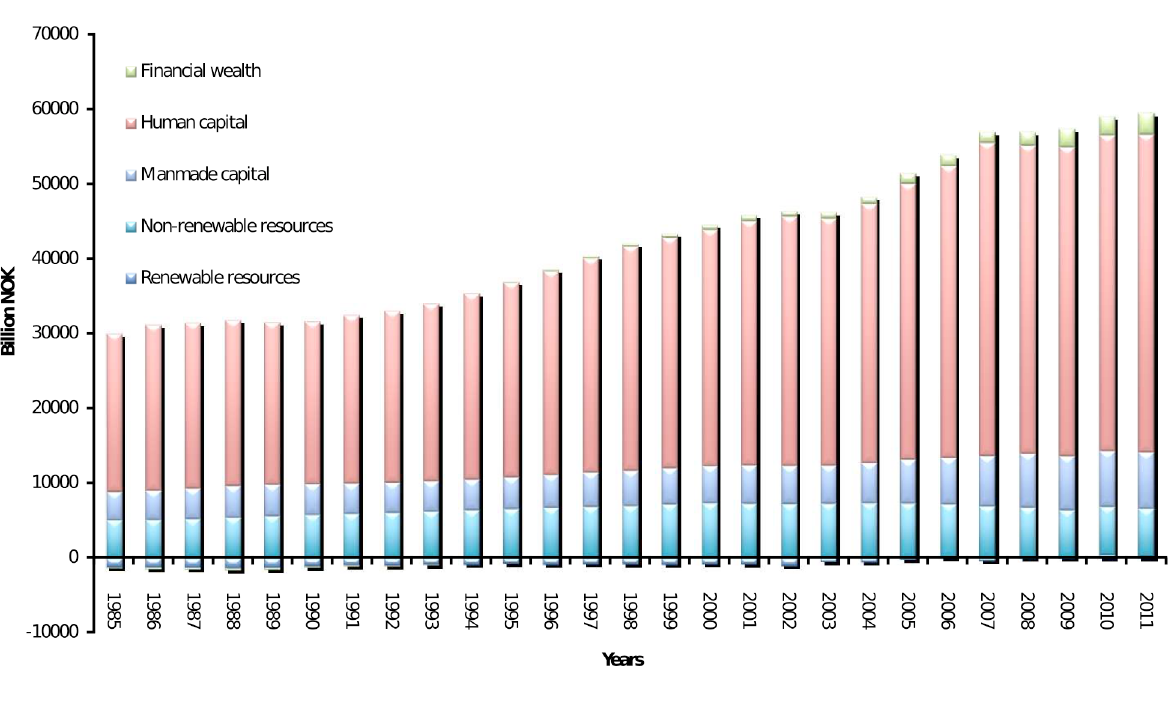
Figure 2. Decomposed national wealth (NW) in Norway